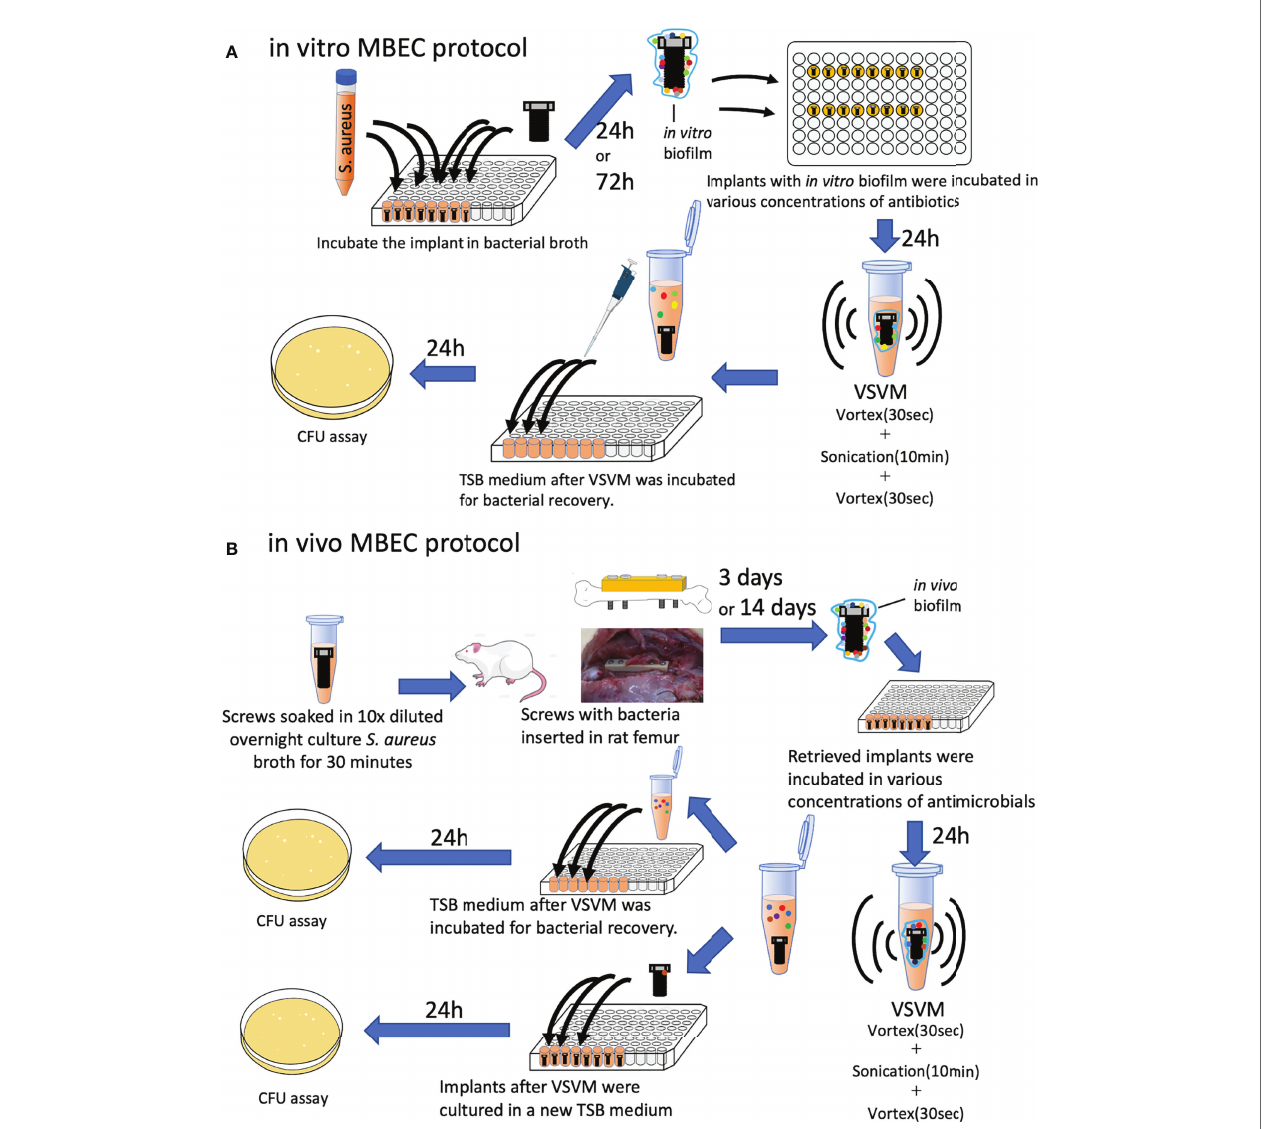
FIGURE 1 | Schematic protocols of (A) in vitro and in vivo (B) MBEC assay in this study. S. aureus : Staphylococcus aureus , VSVM, Vortex-Sonication-Vortex Method, CFU, colony-forming